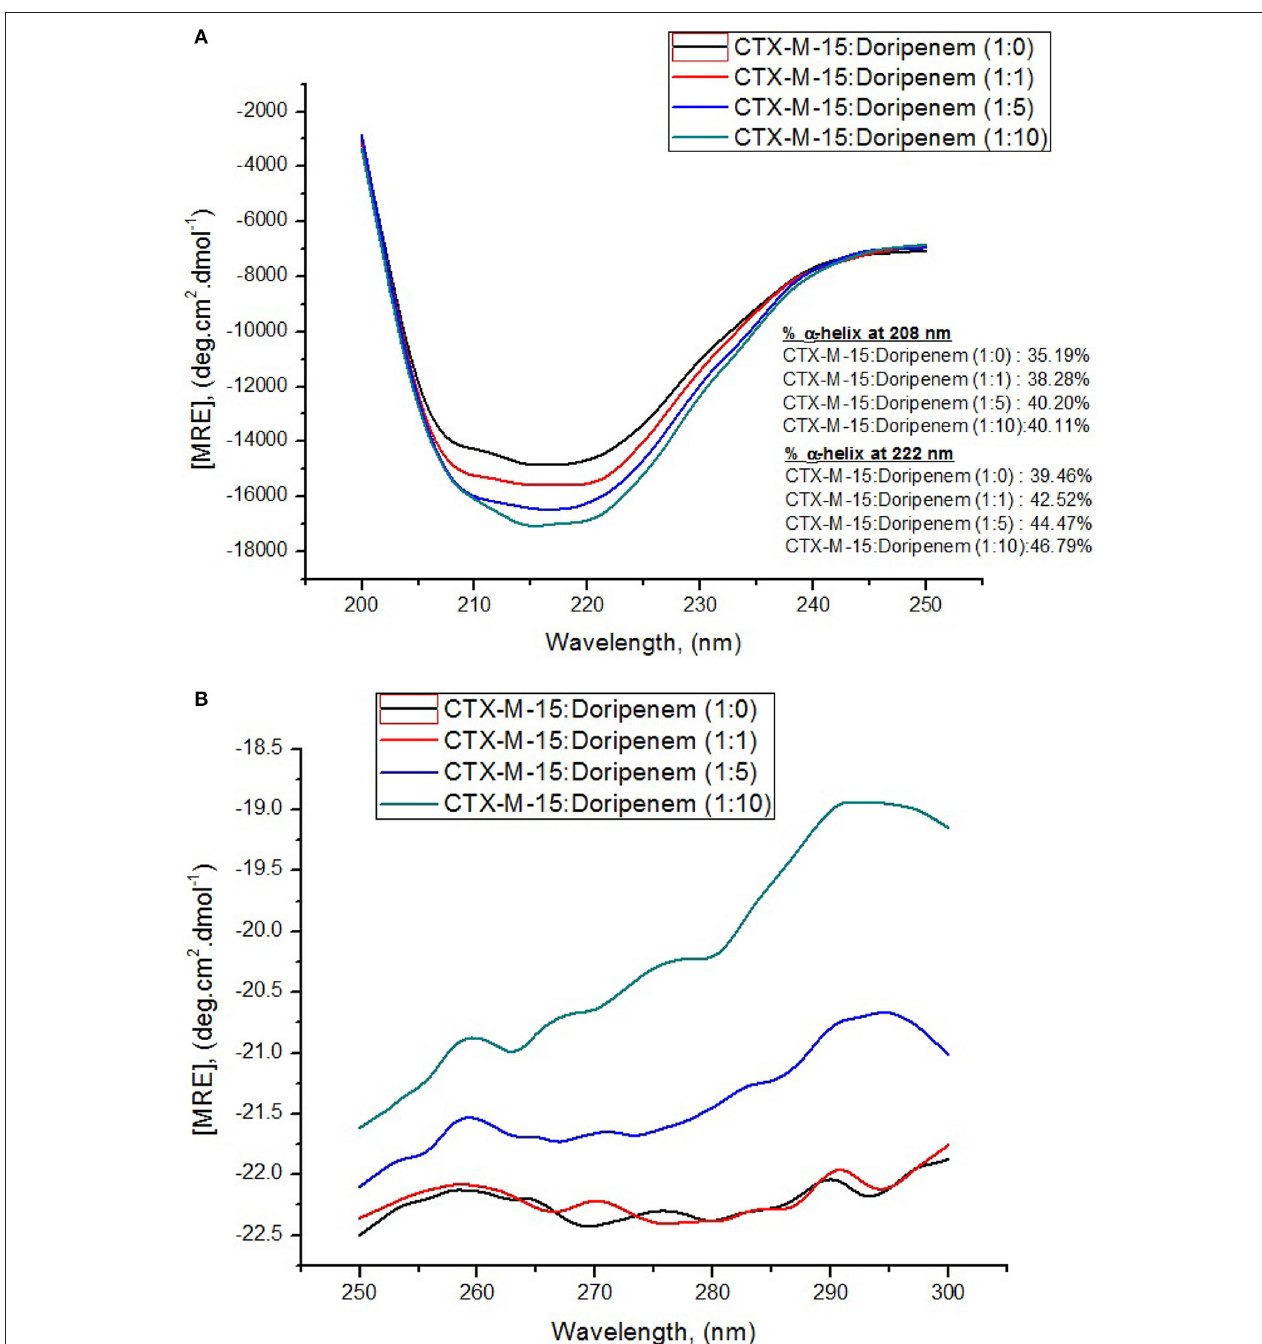
FIGURE 7 | Panel (A) shows Far-UV CD spectral measurements and panel (B) shows Near-UV CD spectral measurements of 5 and 15 µ M CTX-M-15 alone, respectively, along with doripenem in 1:1, 1:5, and 1:10 molar ratios in 50 mM Sodium phosphate buffer pH 7.4 at 298 K.